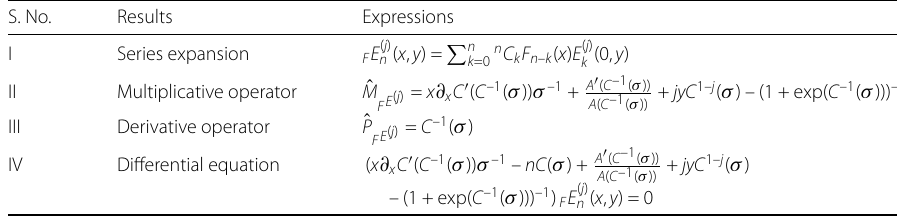
Table 8 Results for Boas–Buck–Euler polynomials F E ( j ) n ( x , y ) S.